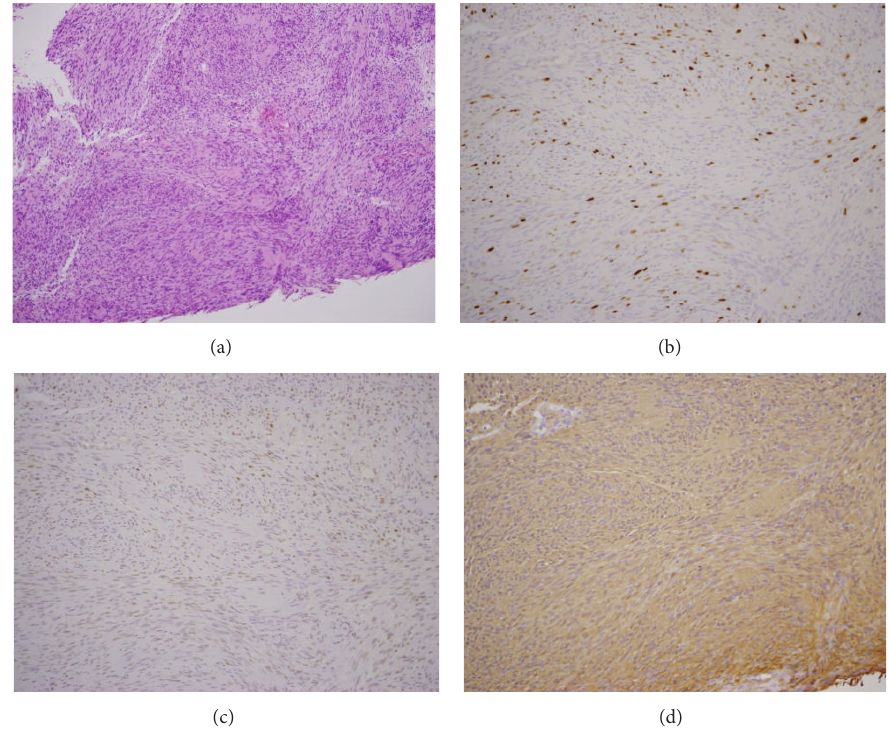
Figure 8: Histopathological image (rebiopsy: a, b: H-E × 100, Ki-67 × 200). Tumor cells containing atypical glands and a spindle nucleus, with fibrous tissues in the submucosa proliferating in a fascicular pattern. Mitosis and proliferation of atypical cells were present, and immunostaining showed a Ki-67 positive rate exceeding 5%. Histopathological image (rebiopsy: c, d: S-100 × 200, p63 × 200). The tumor cells were S-100 positive and strongly p63 positive.